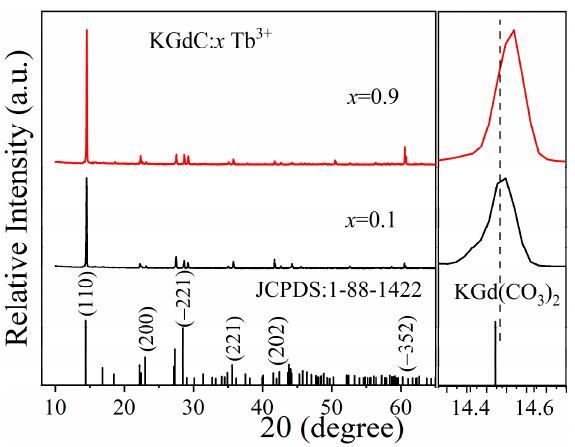
Figure 1. X-ray diffraction patterns of KGdC: x Tb 3+ (x = 0.1, 0.9).